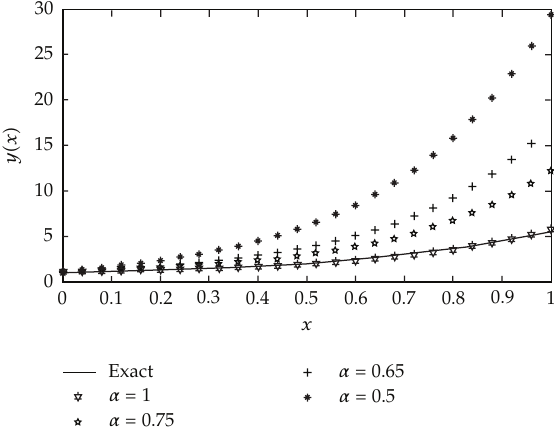
Figure 6: Plots of approx. solution y 3 (cid:3) x (cid:4) for di ff erent values of α .